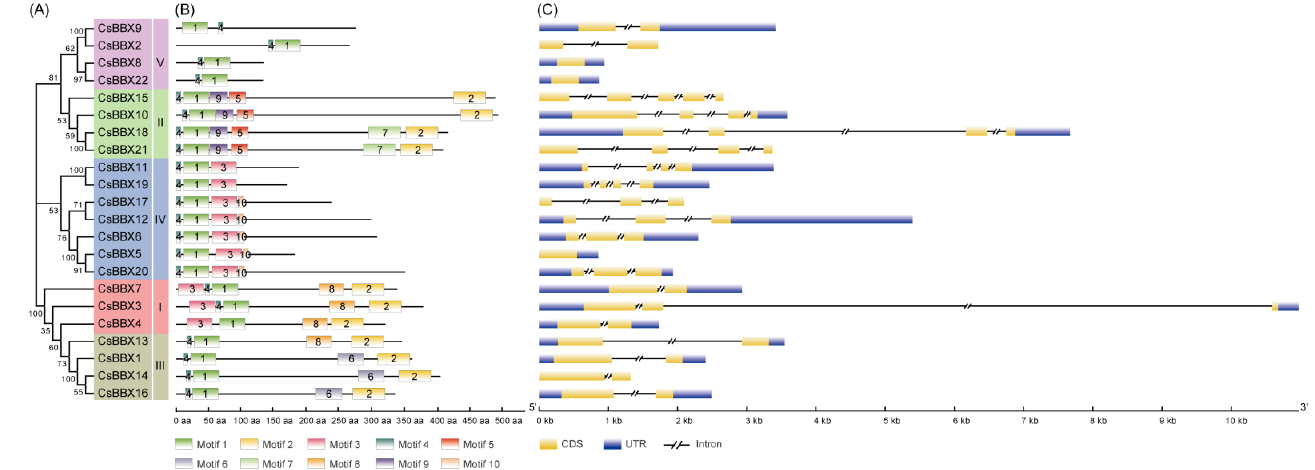
Figure 2. Phylogenetic tree ( A ), conserved motif arrangement ( B ), and gene structure diagram ( C ) of BBX gene family in cucumber. ( A ) The NJ phylogenetic tree was created using the MEGA 7.0 program with 1,000 bootstrap repeats, and CsBBX proteins in the phylogenetic tree were divided into five groups (I–V) with different colors. ( B ) Distribution of conserved motifs in CsBBX proteins identified by MEME. The length and name of conserved motifs are represented by boxes with different colors. ( C ) Gene architecture of the CsBBX genes. The yellow and blue boxes represent the CDSs and UTRs, respectively, while the black lines show the introns.